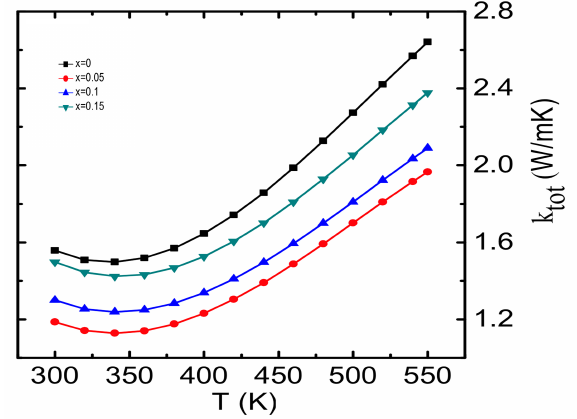
Figure 13: Thermal conductivity as a function of temperature for BiS- bTe + x wt% graphene. All composite samples have lower thermal conductivity than the pristine sample. Reproduced from Ref. [191].